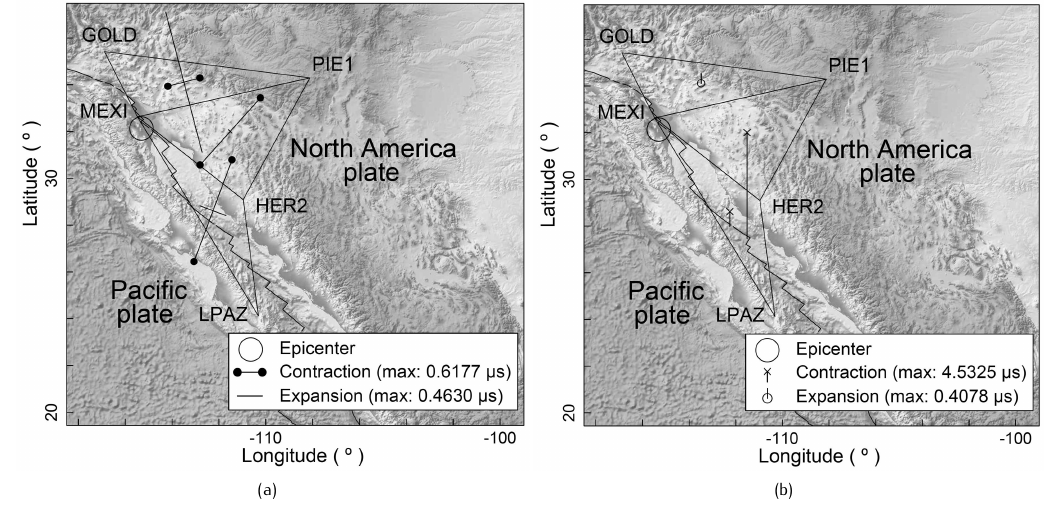
Figure 7. a) Principal components of altimetric strain to the seismic event of 04/04/2010. b) Principal components of altimetric strain to the seismic event of 04/04/2010.